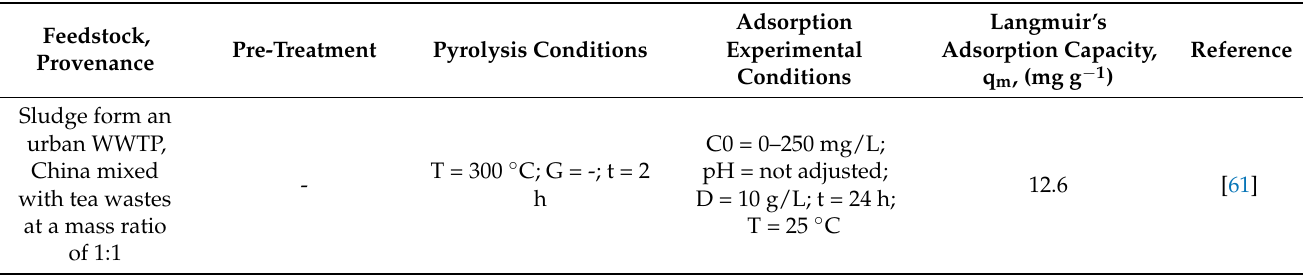
Table 4. Comparison of MB removal efficiency by IS-R and IS-KOH-B with other raw and modified sludge (-: no